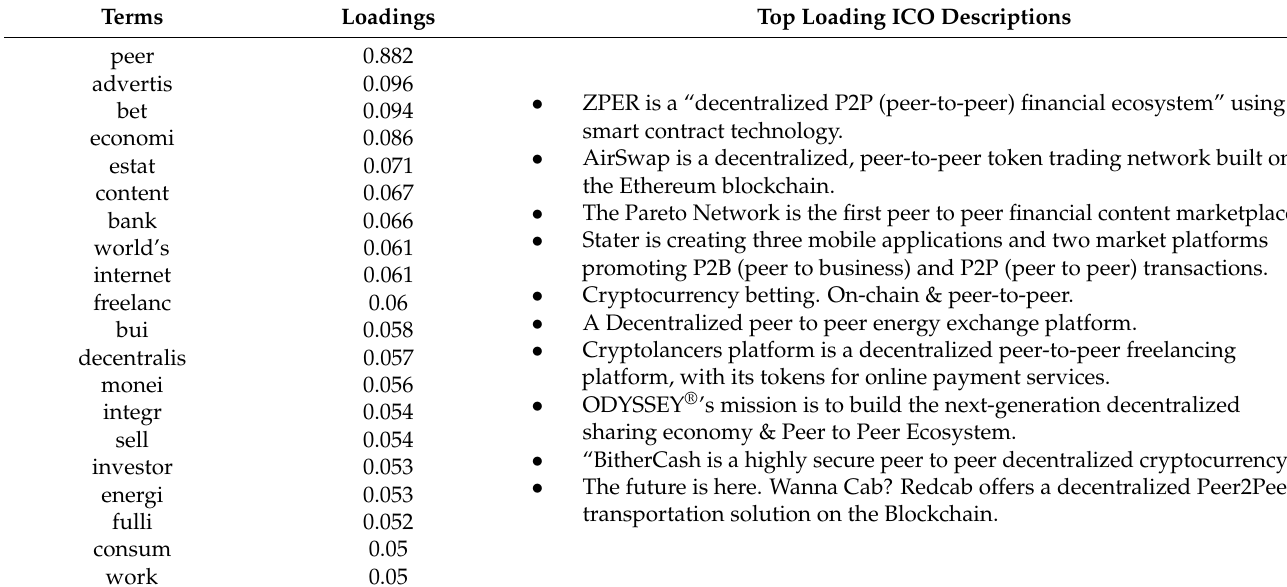
Table 1. F 0 The Market Definition of the Blockchain